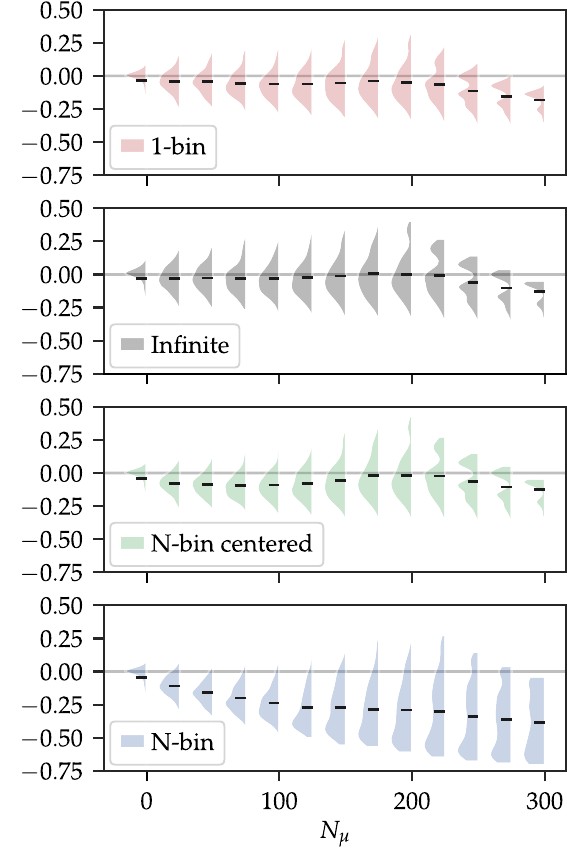
Fig. 7 Relative difference of the muon number estimator to the input number of muons (cf. Eq. (10)) as a function of the input number of muons, for the 1-bin (top), the infinite window (second to top), the N-bin centered (second to bottom), and the N-bin (bottom) strategies. The profiles were generatedfrom sampling uniformly inlog 10 ( r / m ) the average muon profile of proton showers with 17 . 8 ≤ log 10 ( E / eV ) ≤ 18 . 0 and 33 ◦ (cid:2) θ (cid:2) 39 ◦ (0 . 30 ≤ sin 2 θ ≤ 0 .